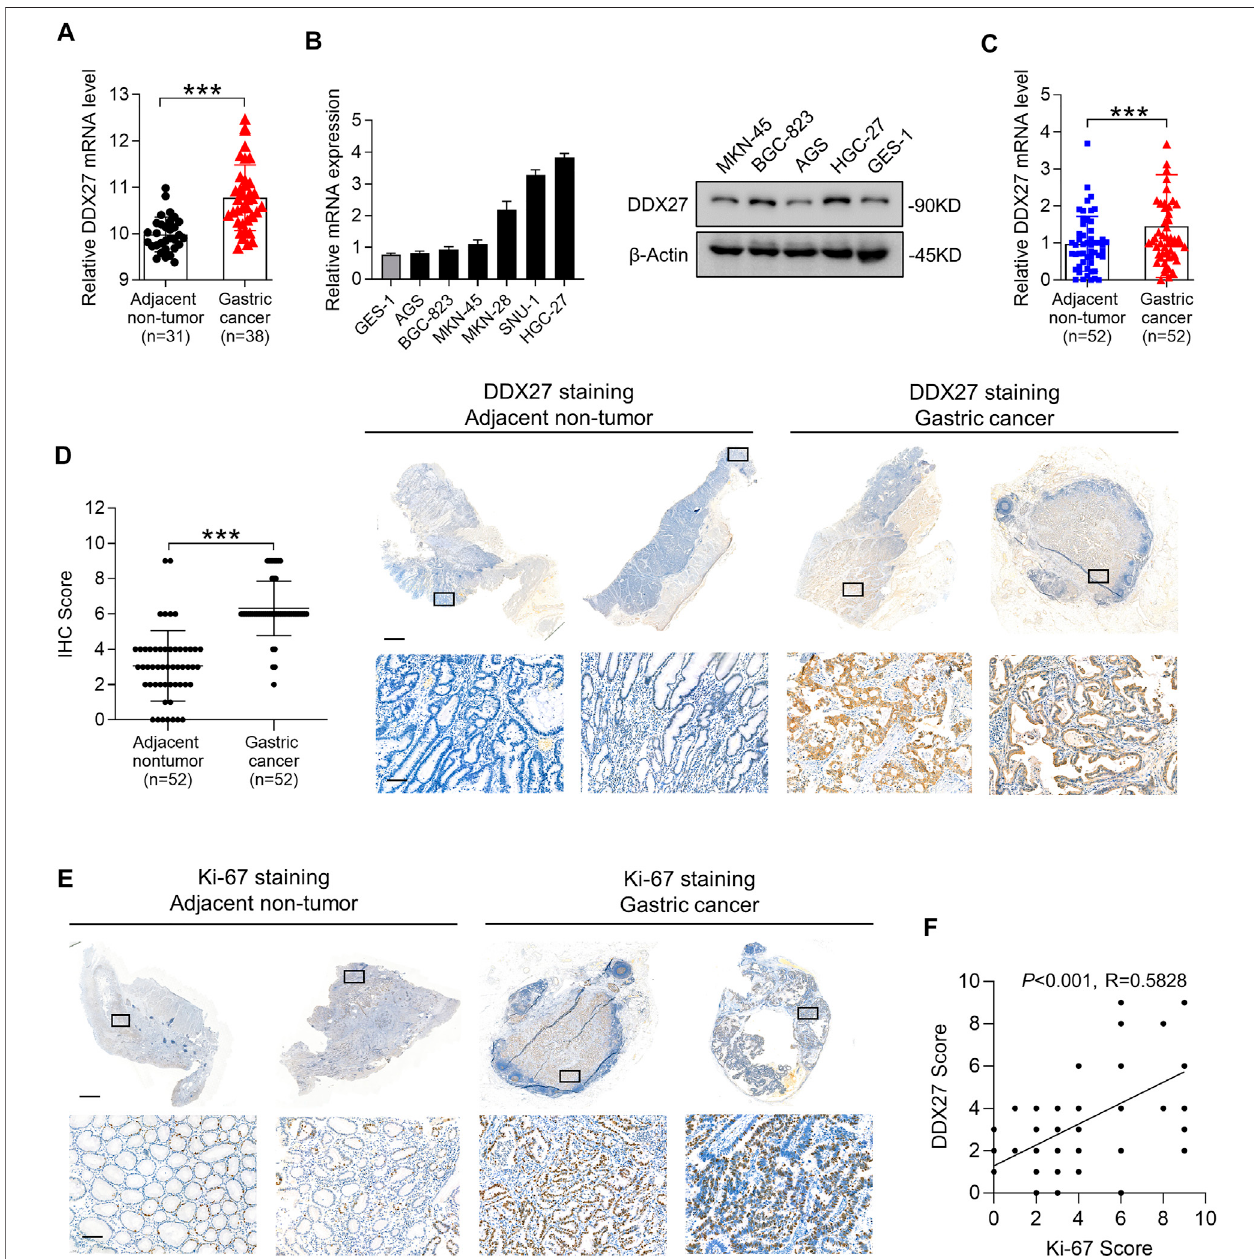
FIGURE1| DDX27exhibitsanelevated expressionpro fi leinGC. (A) DDX27transcriptlevelsbetweentheadjacentnontumorandGCtissuesintheGEOdatabase (GSE13911, *** p < 0.001, by Student ’ s t test). (B) Quantitative reverse transcription PCR (qRT-PCR) (left) and Western blot (right) analyses of the DDX27 expression in thenormalgastricepithelialcellline(GES-1)andgastriccancercelllines(ASG,BGC-823,MKN-45,MKN-28,SNU-1,andHGC-27). (C) DDX27expressionwasanalyzed byqRT-PCRinpairedsurgicallyresected GC( n =52)and adjacentnontumortissues( n =52)(*** p < 0.001,byStudent ’ sttest). (D) IHCscoreofDDX27inclinically paired collectedadjacentnontumor ( n =52)and GCtissues( n =52) (left,*** p < 0.001,byStudent ’ sttest)). Representativeimages ofstainingwereexhibited intheright. Scale bars: 1000 μ m (up) or 100 μ m (below). (E) IHC staining images of Ki-67 in the adjacent nontumor ( n = 52) and GC tissues ( n = 52). Scale bars:1000 μ m (up) or 100 μ m (below). (F) Correlation analysis between DDX27 and the Ki-67 IHC staining score. ( p < 0.001, R = 0.5828, by Pearson correlation method). n ≥ 3, the data are presented as the mean ± standard deviation (SD). A high DDX27 expression indicates poor clinical prognosis.